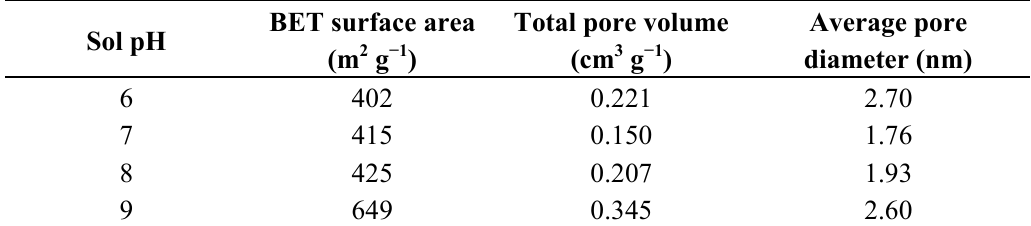
Table 1. Surface properties of the bulk silica